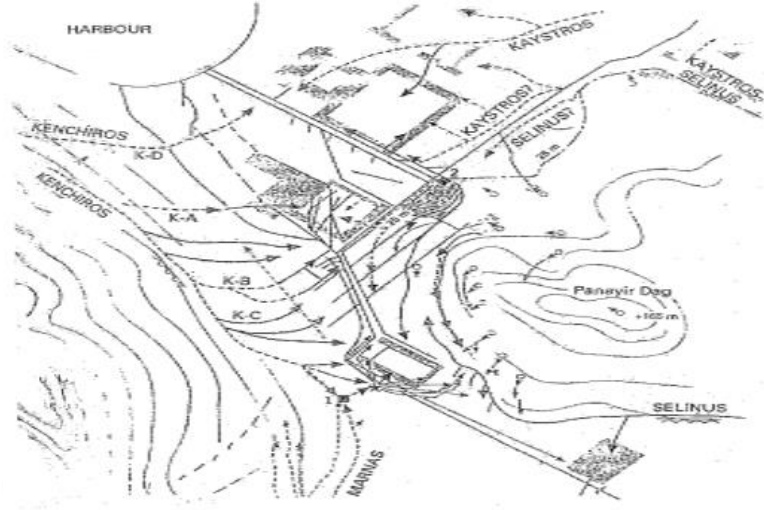
Figure 59. Multiple Roman branched aqueducts [1], p. 298.